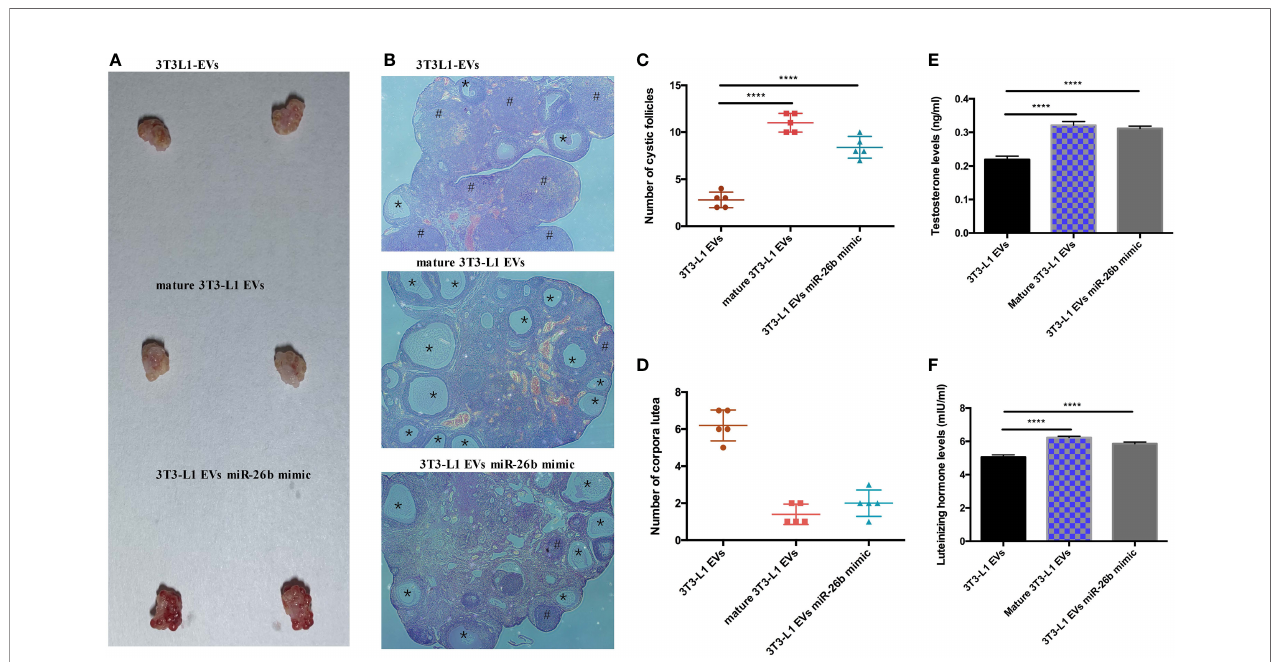
FIGURE 9 | Adipocytes-derived extracellular vesicles regulated miR-26b induced the PCOS in mice. (A) Gross observation of ovaries when injected intravenously with 3T3-L1 extracellular vesicles (roof), mature 3T3-L1 extracellular vesicles (middle), and 3T3-L1 EVs miR-26b mimic (bottom). (B) Hematoxylin and eosin staining of representative ovaries; the cystic follicle is indicated by a # hashtag, while the corpora lutea are indicated by asterisks. (C) Quantitative analysis of cystic follicles. (D) Quantitative analysis of corpora lutea. (E) Quantitative analysis of testosterone levels. (F) Quantitative analysis of luteinizing hormone levels; ****p <